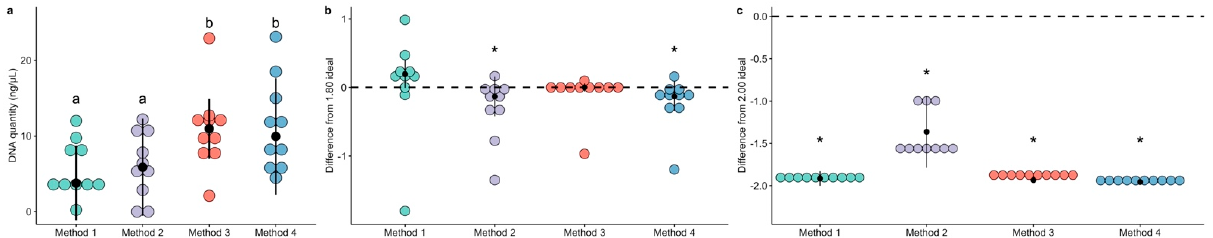
Figure 1. The quantity and quality of extracted DNA varies by commercial extraction method. DNA quantity was measured with a Qubit instrument and compared between methods ( a , Dunn test p < 0.05, indicated with lowercase letters). DNA purity was assessed with NanoDrop and the standard ratios were transformed to reflect the differences from the ideal purity value. Each method was compared to the ideal value; the ideal for A260/280 is 1.80 ( b , Wilcox rank sum test p < 0.05, indicated with asterisks) and the ideal value for A260/230 is 2.00 ( c , Wilcox rank sum test p < 0.05, indicated with asterisks).